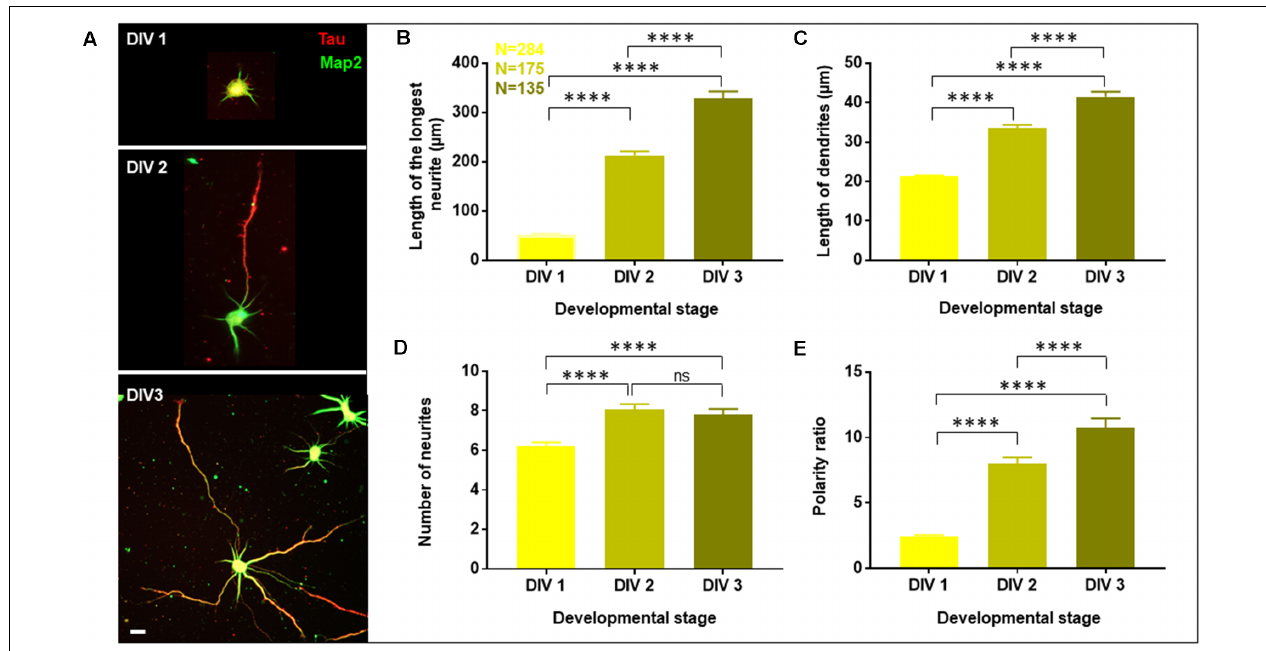
FIGURE 1 | Developmental profile of optimized primary cultures of rat hippocampal neurons. Neurons were grown to three developmental stages namely DIV 1, 2, and 3, fixed and labeled with Tau (red) and Map2 (green) as axonal and dendritic markers, respectively. (A) A gallery of cells at DIV 1, 2, and 3 is presented. (B–E) Neuronal development was assessed by quantifying the length of the longest neurite (B) , length of dendrites (C) , number of neurites in each cell (D) , and the polarity ratio (E) , which was calculated from the ratio of the longest neurite to the average length of dendrites of each cell. N denotes the number of cells from four independent cultures. One-way Anova was performed to test the significance of the difference between the means. ∗∗∗∗ p < 0.0001, ns denotes non-significant. Scale bar indicates 20 µ